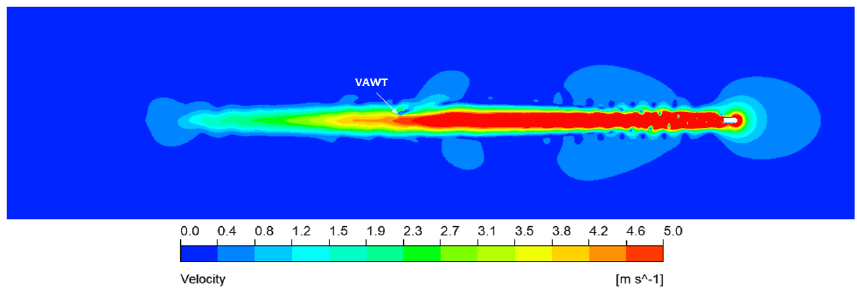
Figure 11. Velocity contour at t = 7 s using medium mesh density.